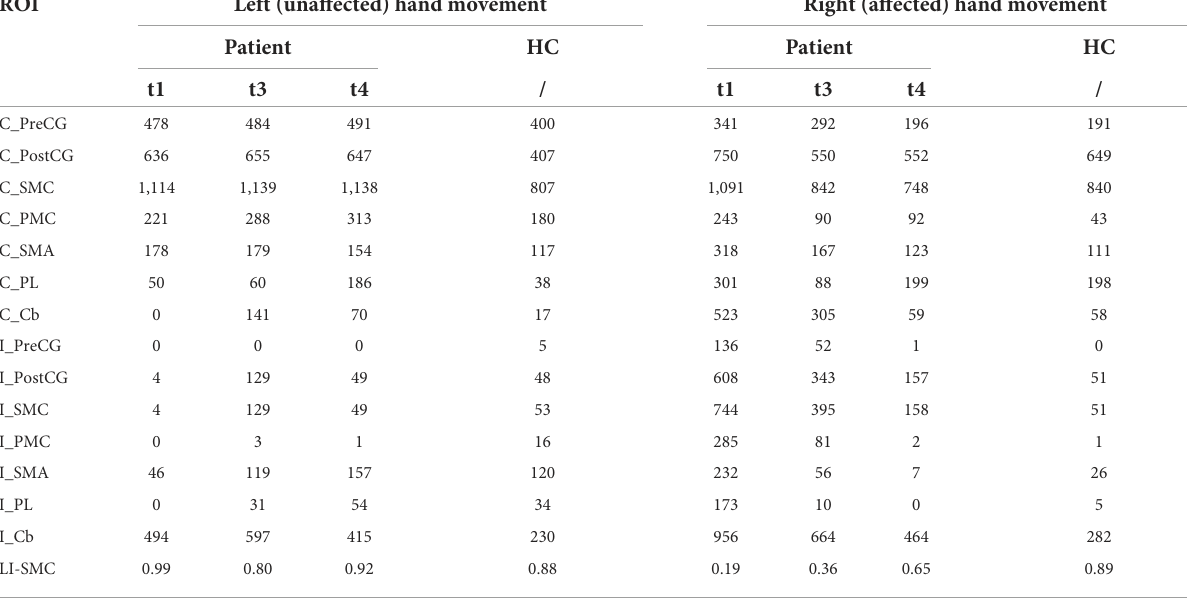
TABLE 2 Number of significantly active voxels in each neural region during passive movement for patient and healthy control. ROI Left (unaffected) hand movement Right (affected) hand movement